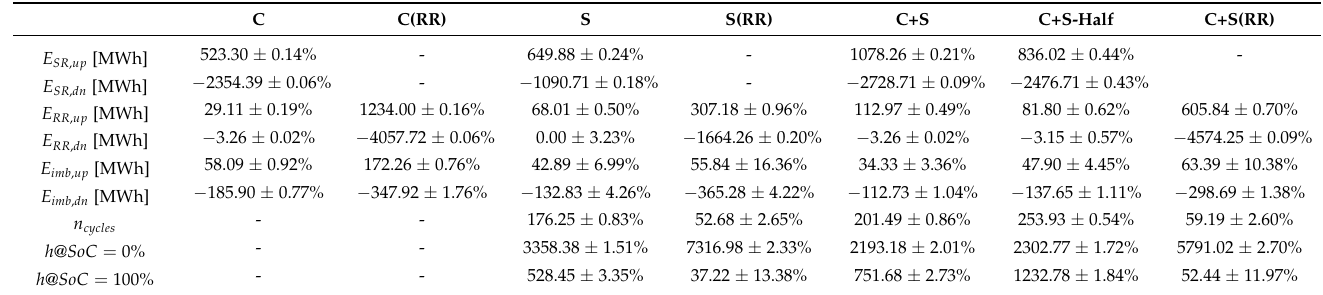
Table 4. Detail of the EVU market exchanges and ESS usage, and related statistical